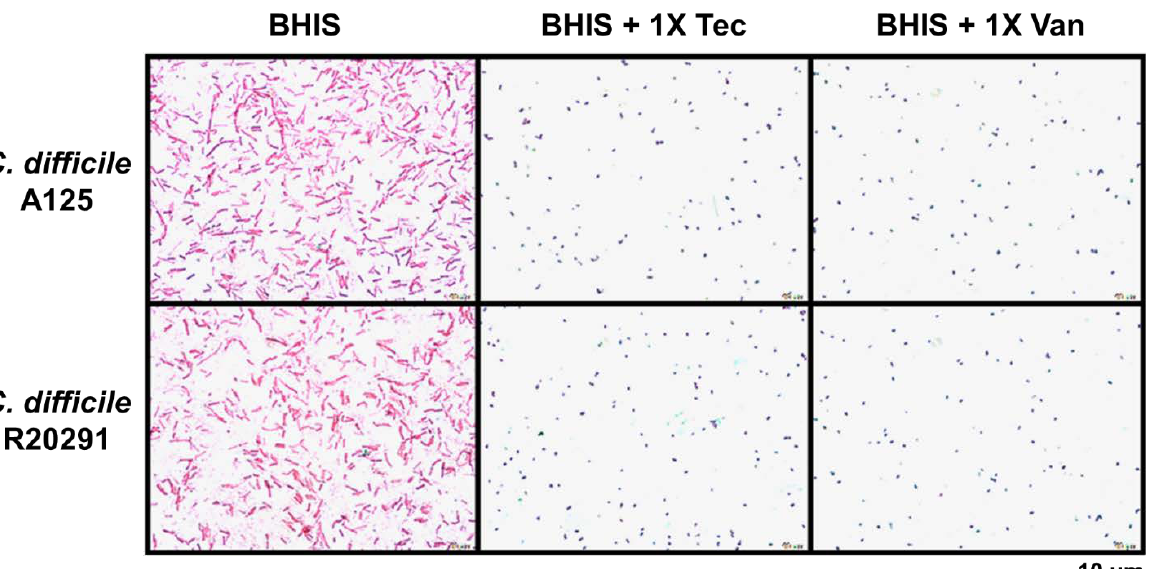
Figure 4. Teicoplanin and vancomycin at their respective MICs do not inhibit initiation of spore germination as revealed by differential staining. C. difficile spores were incubated with 1× MIC of either teicoplanin or vancomycin supplemented with BHIS medium for 3 h. Germinated cells were stained by Wirtz–Conklin staining (5% malachite green/0.5% safranin). Spores were greenish-blue spheres and germinated cells appeared to be pink/purple spheres. All the micrographs were taken at a magnification of 1000×. All the experiments were repeated in triplicates to ensure the reproducibility of the results. Abbreviations: Tec = teicoplanin, Van = vancomycin, BHIS = Brain heart infusion broth supplemented with 0.1% sodium taurocholate.